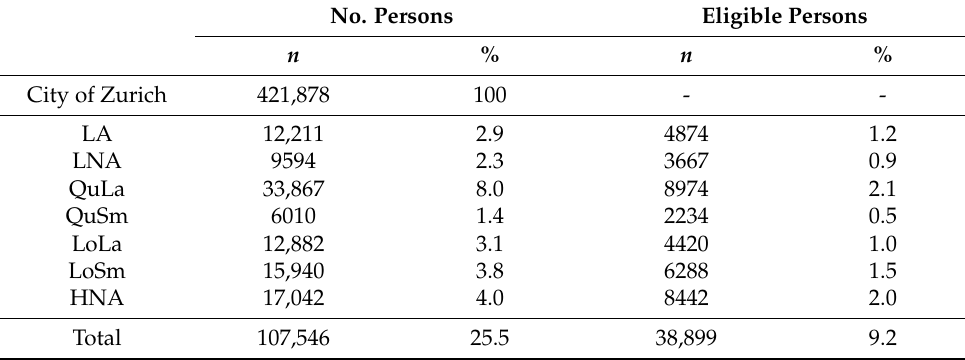
Table 2. Numbers ( n ) and shares (%) of persons in total eligible for participation in each of the study areas compared with the city of Zurich. The percentages refer to the total population of the city of Zurich.